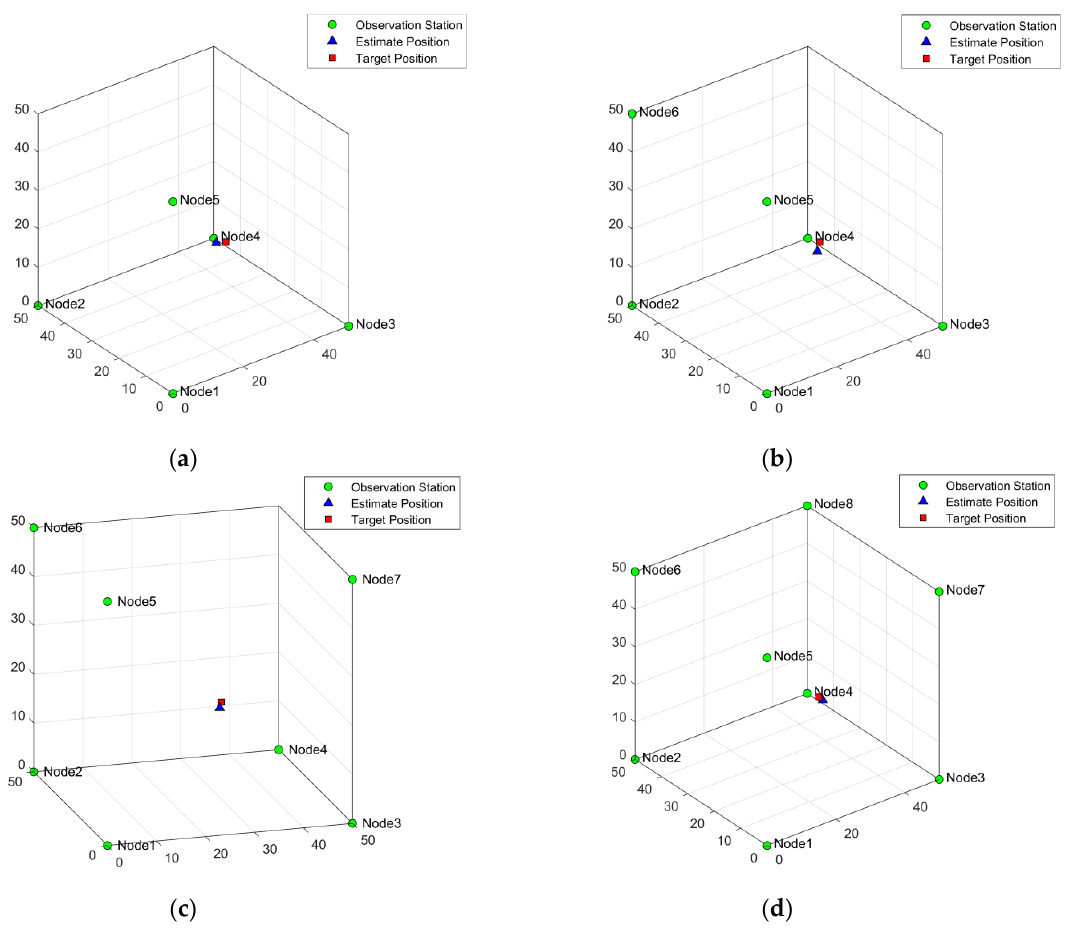
Figure 8. 3D-scene positioning diagram: ( a ) 3D five-base stations; ( b ) 3D six-base stations; ( c ) 3D seven-base stations; ( d ) 3D eight-base stations.